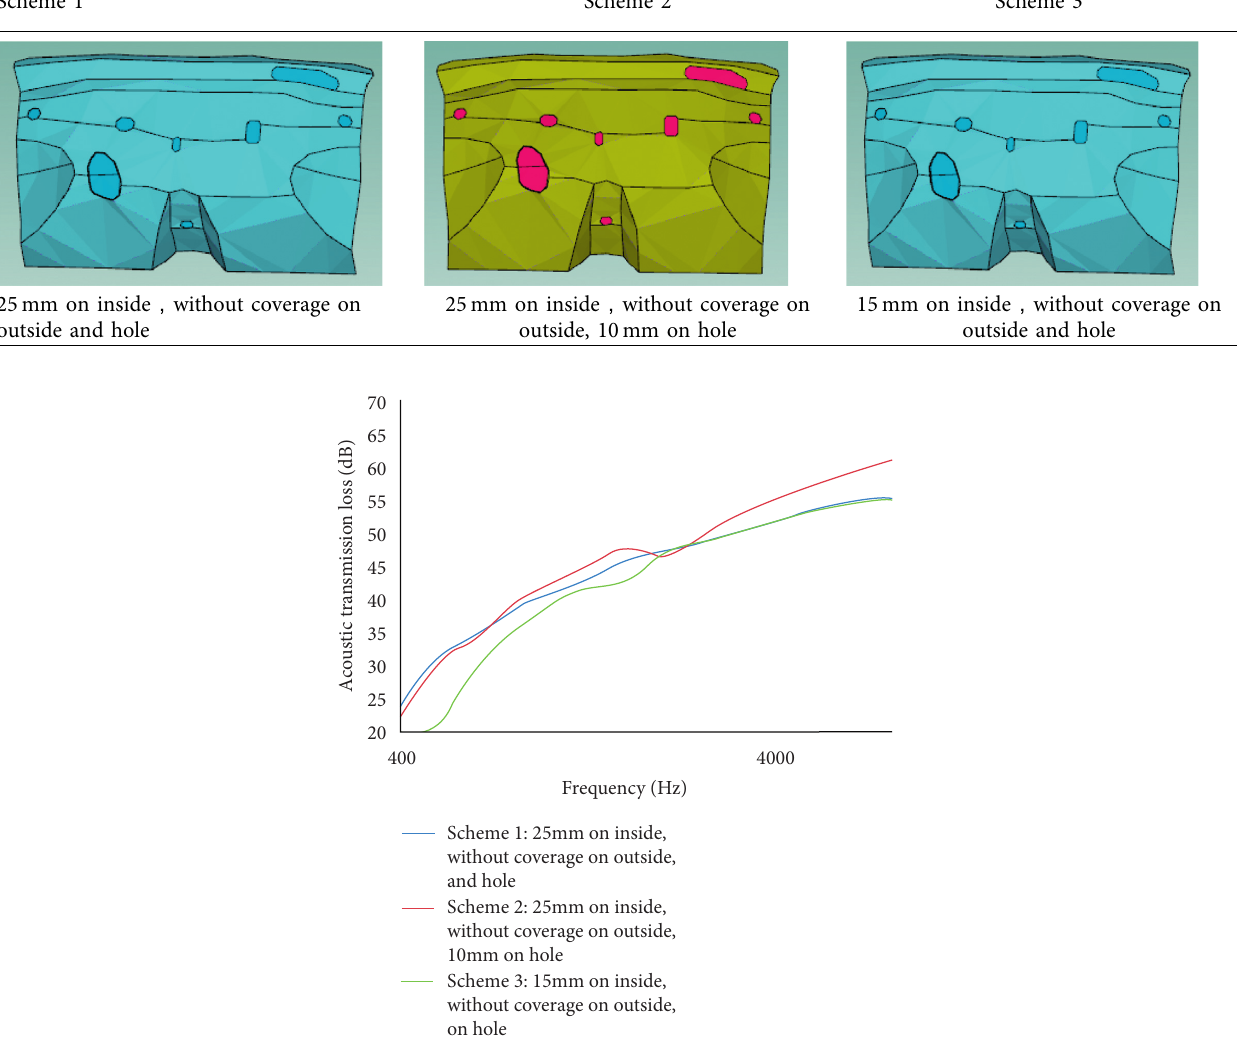
Figure 10: Impact of thickness on sound insulation